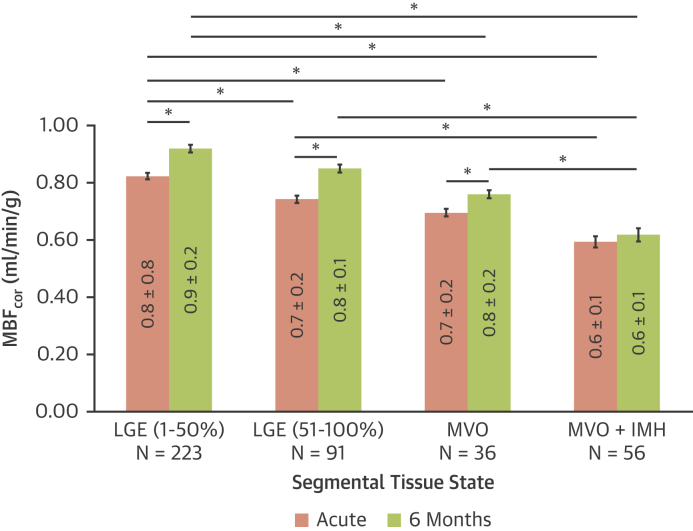
MBFcor Changes Over 6M in Acutely Infarcted MyocardiumMyocardial blood flow corrected (MBFcor) improves significantly at 6 months (6M) in all segments, with the exception of segments with an acute presentation with microvascular obstruction (MVO) and intramyocardial hemorrhage (IMH). Bars are SEM. Mean values in the bars are reported with SD. ∗p < 0.001. LGE = late gadolinium enhancement.